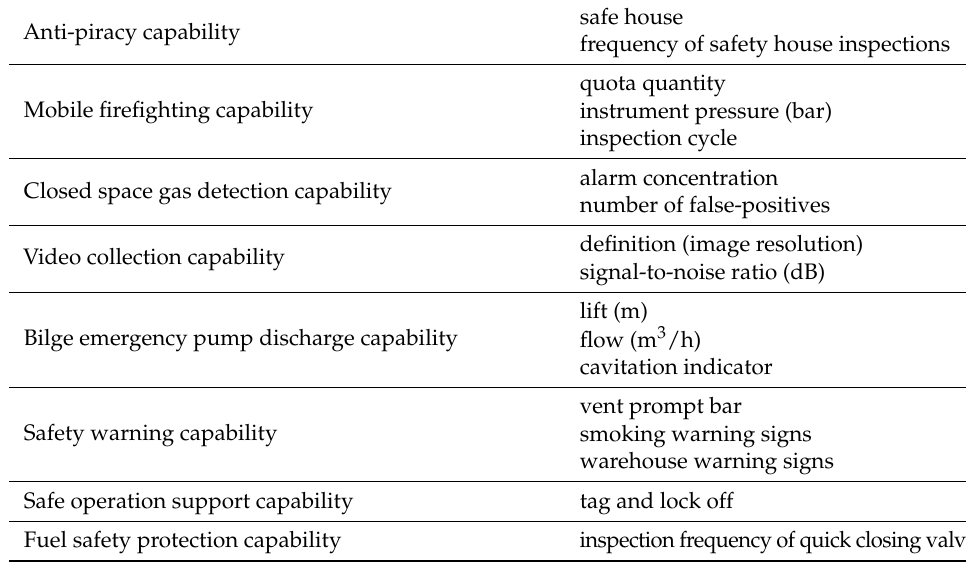
Table 5. Capability indicators of physical